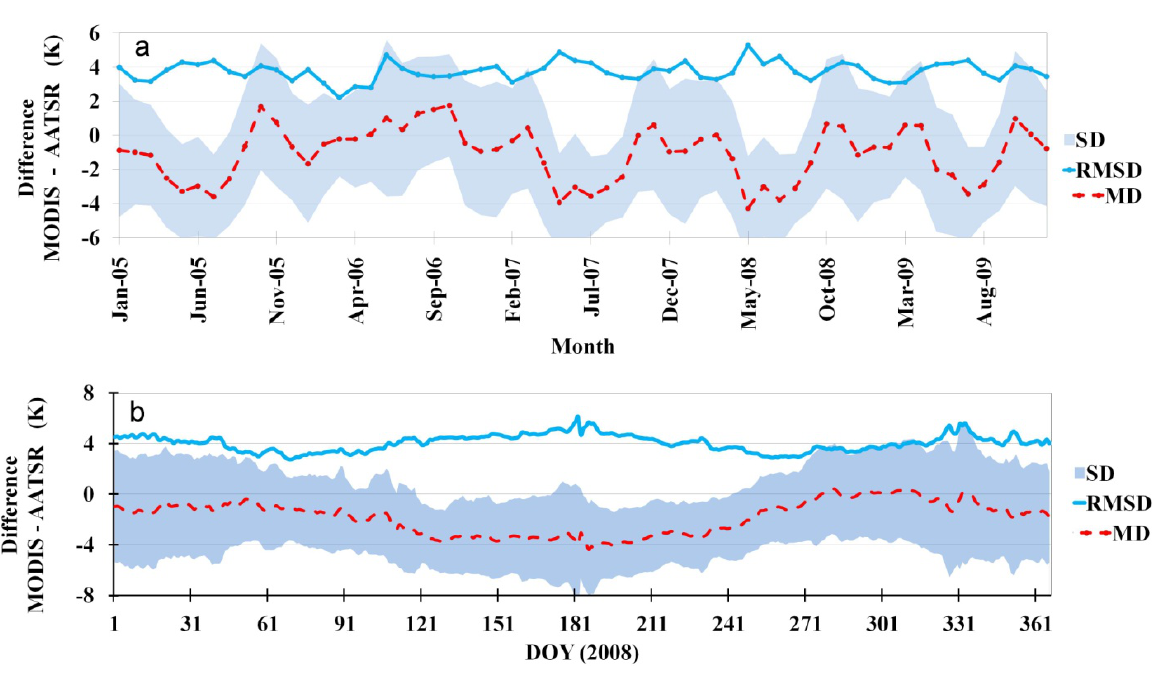
Figure 5. ( a ) Mean-difference (MD) and root-mean-square-difference (RMSD) between UW-L3 monthly LST of MODIS and AATSR data, outliers are not plotted for clarity; ( b ) bias (MD and RMSD) between UW-L3 weekly LST of MODIS and AATSR data during year 2008; outliers (DOY 35, 184 & 185) are excluded and replaced by interpolated values for